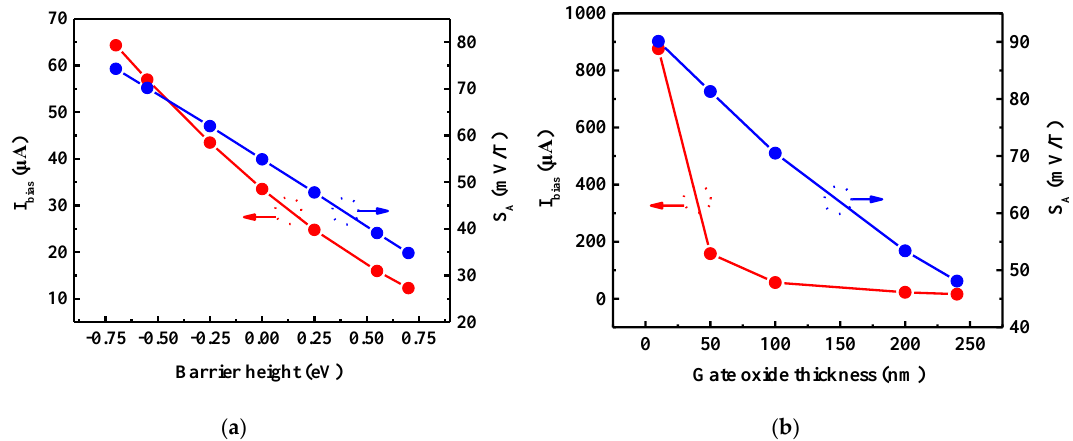
Figure 5. Bias current ( I bias ) and absolute sensitivity ( S A ) versus ( a ) the barrier height of the gate-channel and ( b ) the gate oxide thickness.